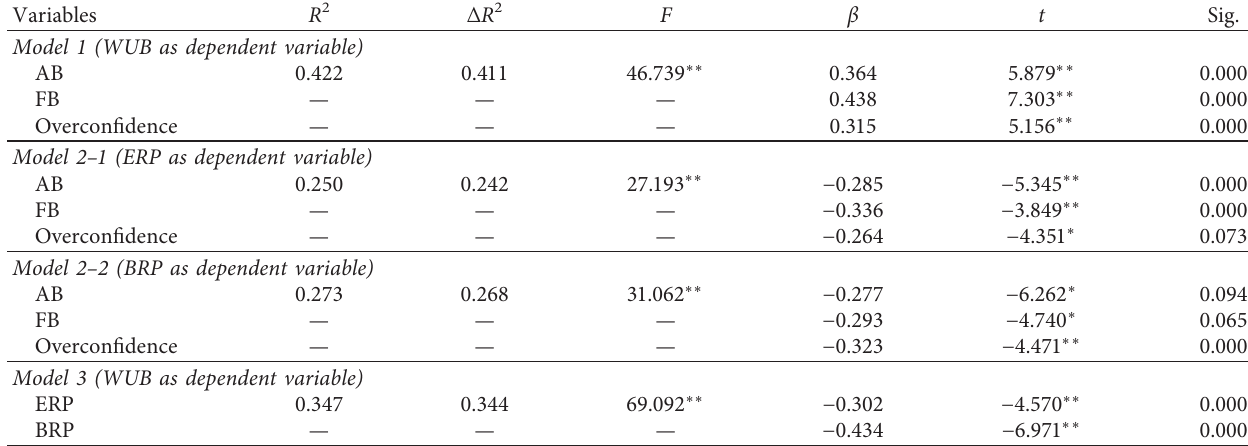
Table 5: Statistical results of four models for direct effects.